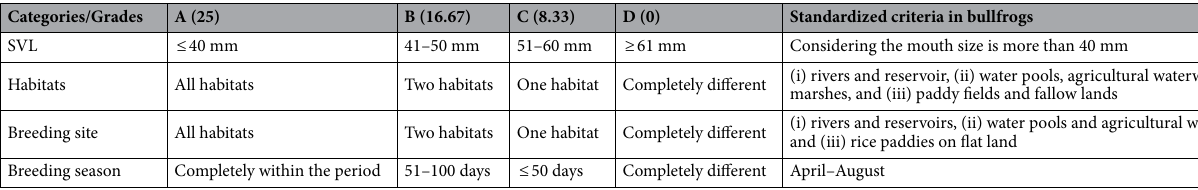
Table 1. The criteria and process of grading and scoring for risk assessment for the anurans from the American bullfrogs in South Korea. Here, SVL = Snout to vent length; A, B, C, D are grades and the numbers in the parentheses are the representative